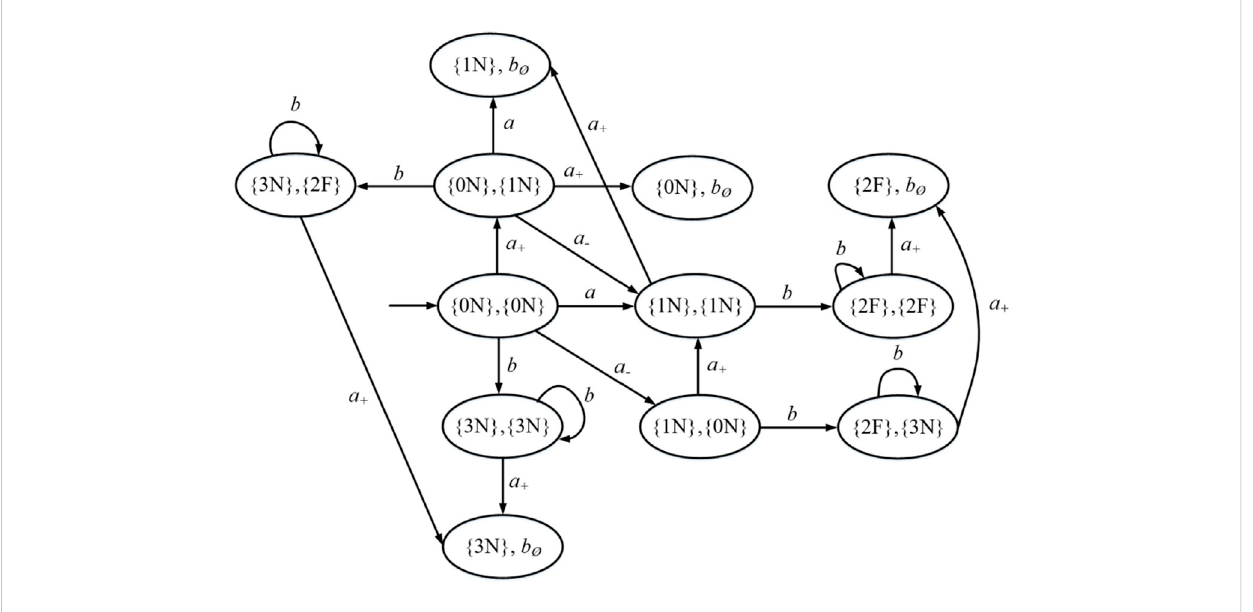
FIGURE 5 Hybrid diagnoser D h in Example